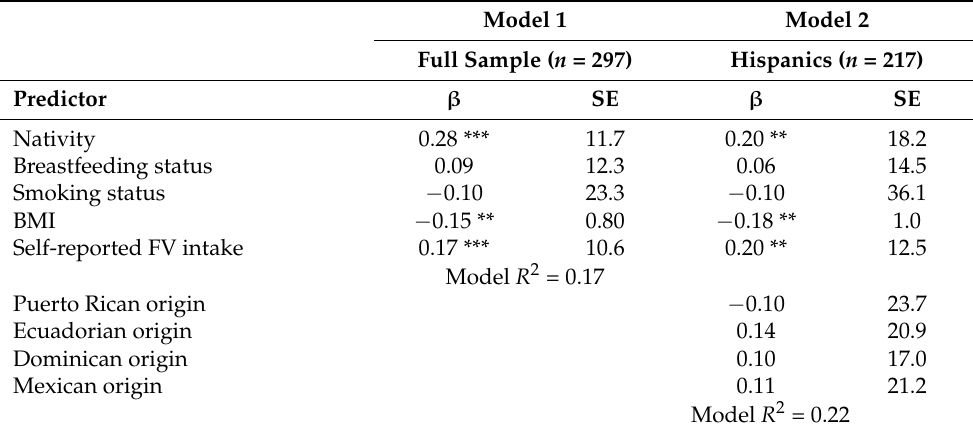
Table 2. Regression analyses of participant characteristics and self-reported fruit and vegetable intake predicting Veggie Meter